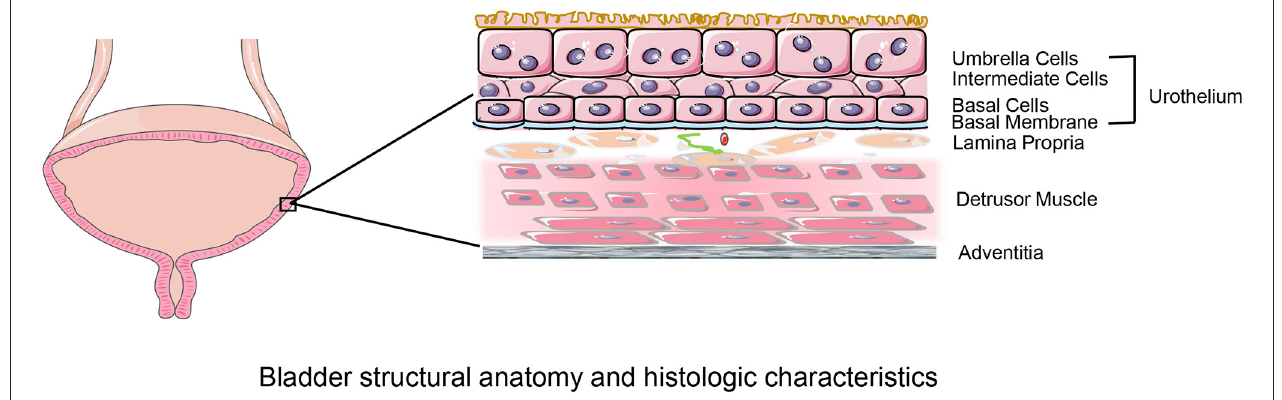
FIGURE 1 | Bladder structural anatomy and histologic characteristics. The bladder walls consist of four layers: urothelium; lamina propria; muscular layer and serosal layer. The urothelium, composed of umbrella cells, intermediate cells, basal cells, basal membrane lines the bladder lumen and forms the urine-body barrier. The lamina propria is a connective tissue layer that contains nerves and vessels. The detrusor muscle layer consisted of longitudinal and transverse muscles that provides structural support to the bladder and facilitates its physiological functions of filling and emptying. The serosal layer covering the external surface is the outermost